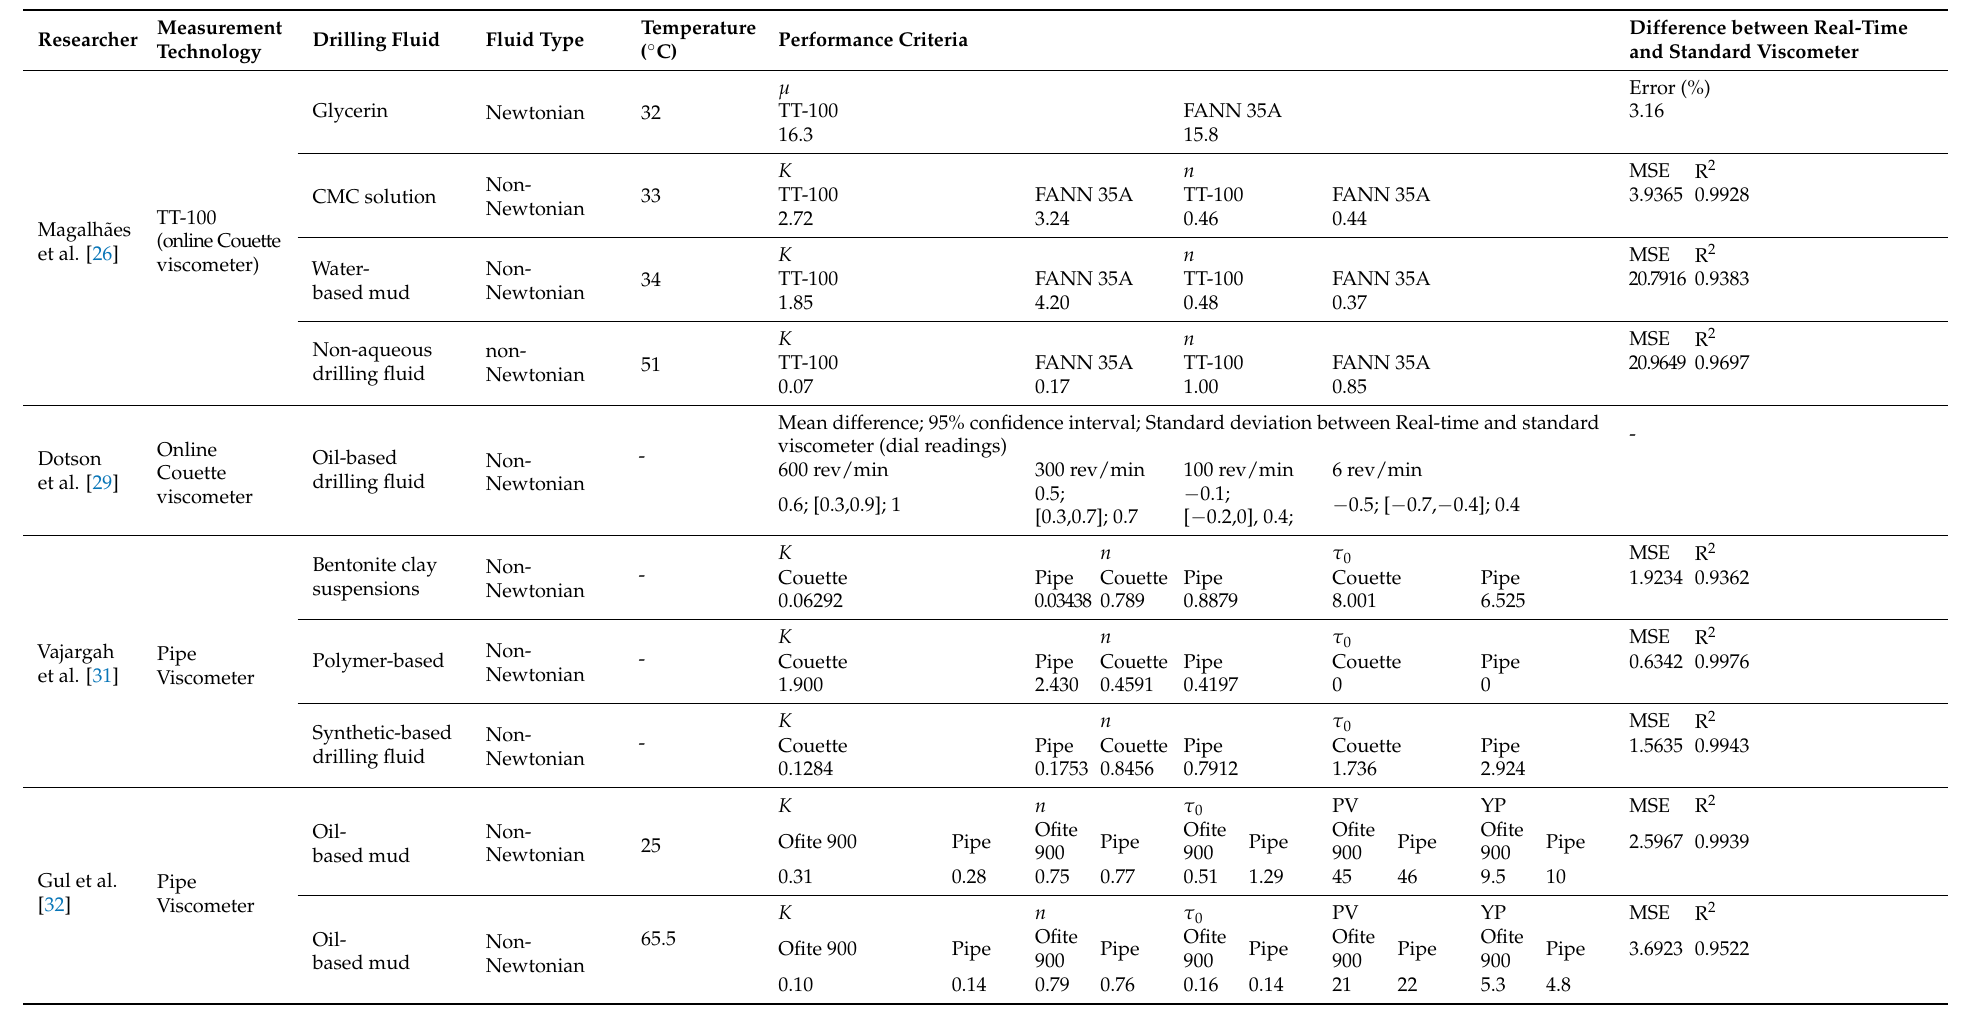
Table 1. Comparative studies of online Couette viscometers and pipe viscometers conducted by previous